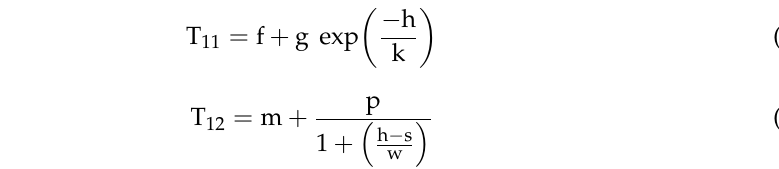
Table 2. Hydration values saturating all sorption sites in the aerogel and corresponding to their relaxation times.